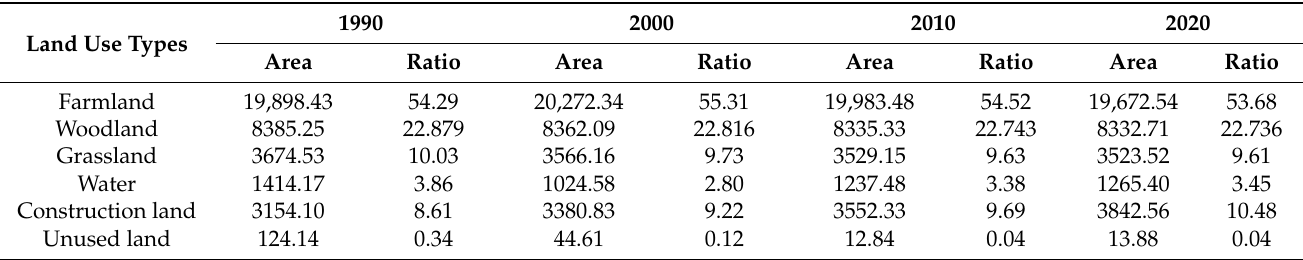
Table 6. Area (km 2 ) and ratio (%) of land use types in the Yellow River Basin (Henan section) from 1990 to